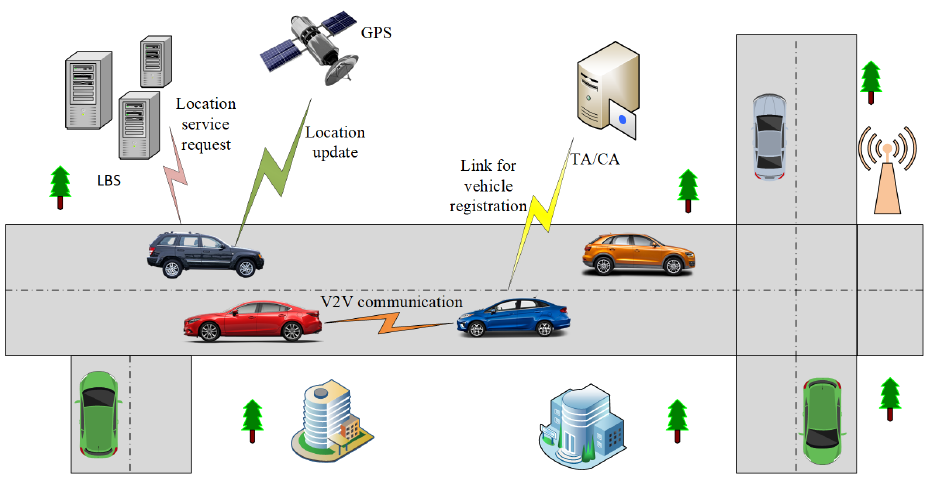
Figure 2. Basic system